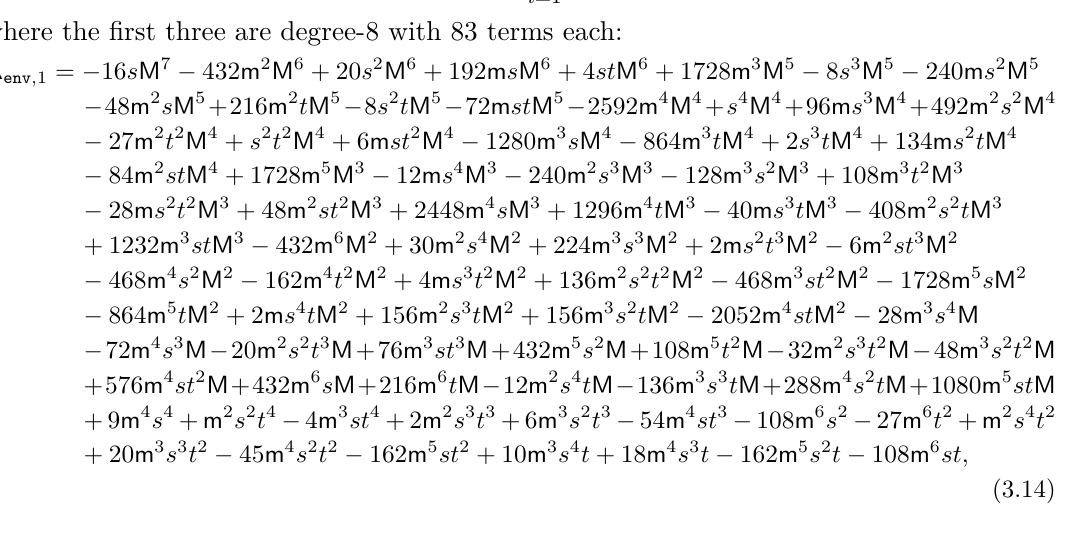
Figure 3. Real part of the Landau discriminant ∇ Thm. 3.1 with dehomogenization M = 1 . The two components are illustrated in blue (degree 2 ) and orange (degree 4